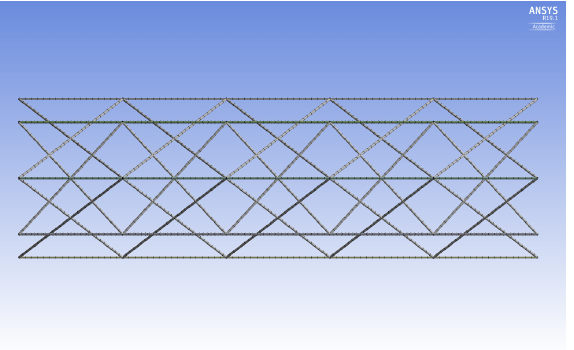
Figure 2. Side view of IsoTruss structure with outer longitudinal members (i.e., OLC)